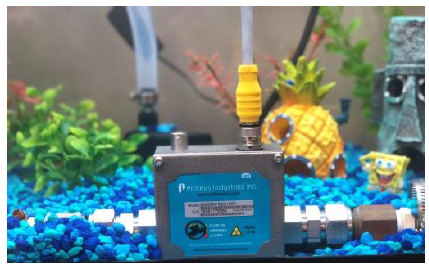
Figure 7. Dunk Life Test, 300 mm Showcase.